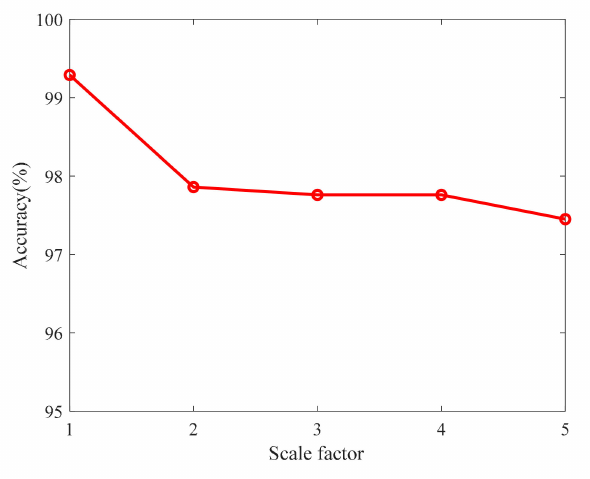
Figure 10. Maximum diagnostic accuracy at different scales.